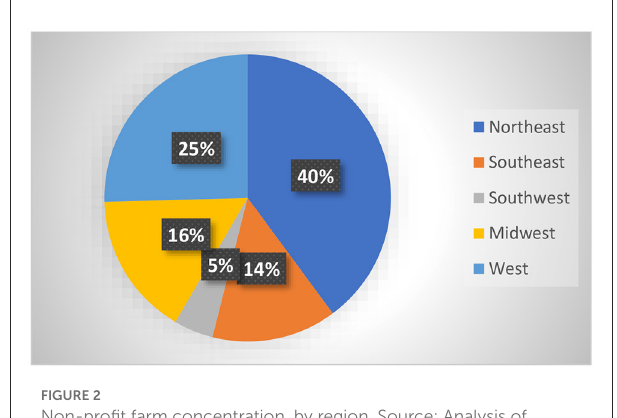
FIGURE2 Non-profit farm concentration, by region. Source: Analysis of GuideStar data.